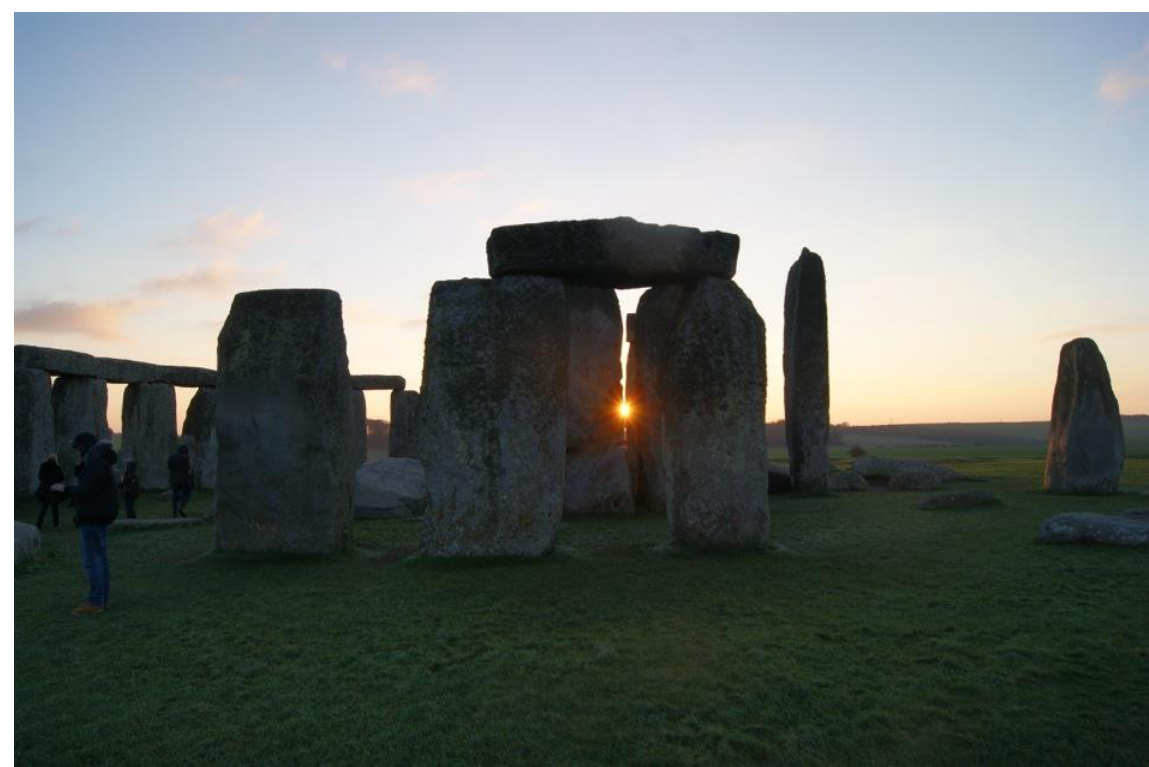
Figure 8. In the week of the winter solstice the rising sun shines through prepared gaps between the sarsens in a direction that is close to and parallel to the recumbent Altar Stone. (Photograph by the author, 27 December